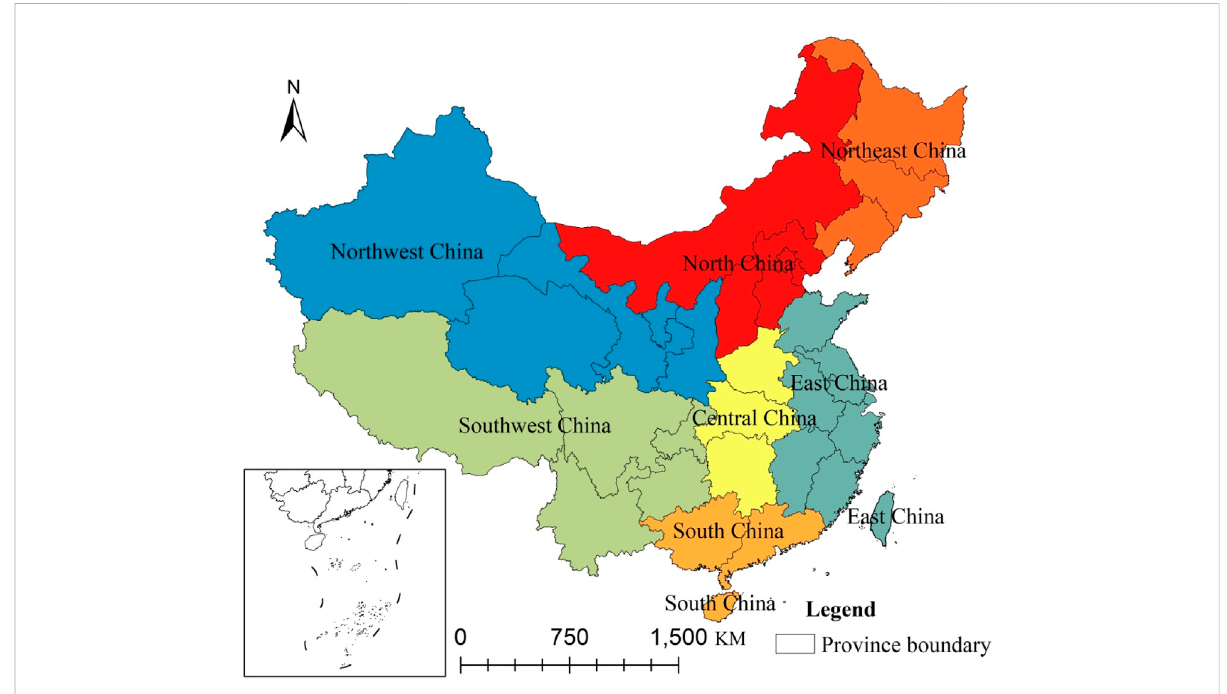
FIGURE 1 Map of the study area showing the seven regions in China considered in the